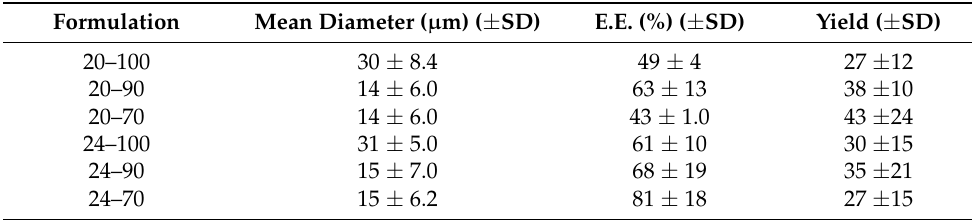
Table 2. Overall technological features of the produced MPs.